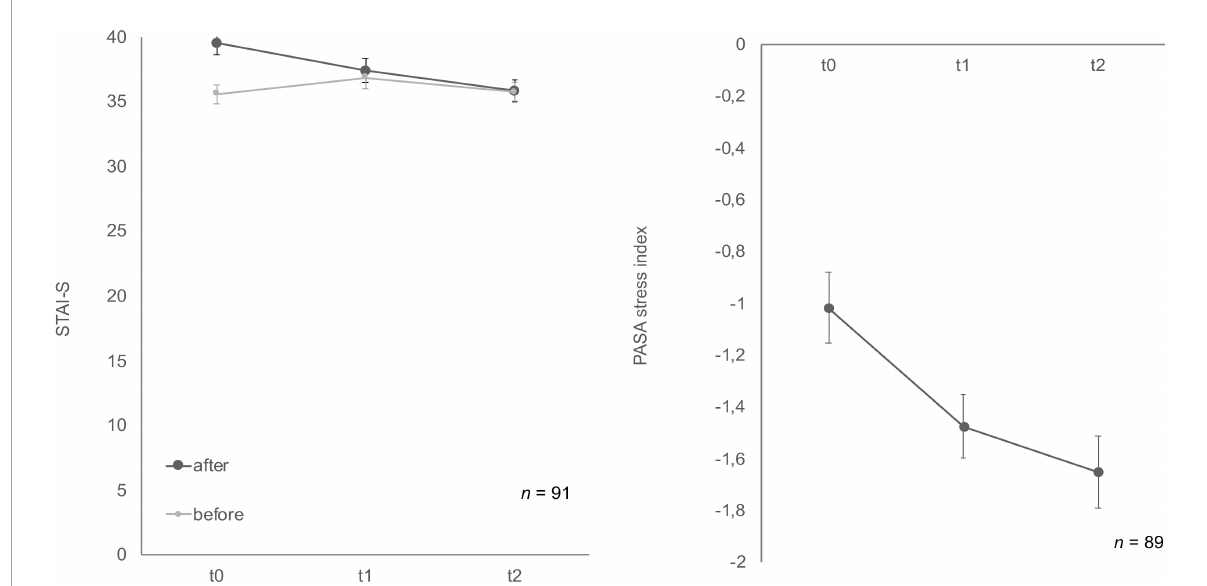
FIGURE4 Stress response of state-trait-anxiety inventory: before and after mental stress task (STAI-S) before/after mental stress and primary appraisal secondary appraisal (PASA) during Trier Social Stress Test for groups (TSST-G) for the three measurement points (t0, t1, t2). Values are means ( ±